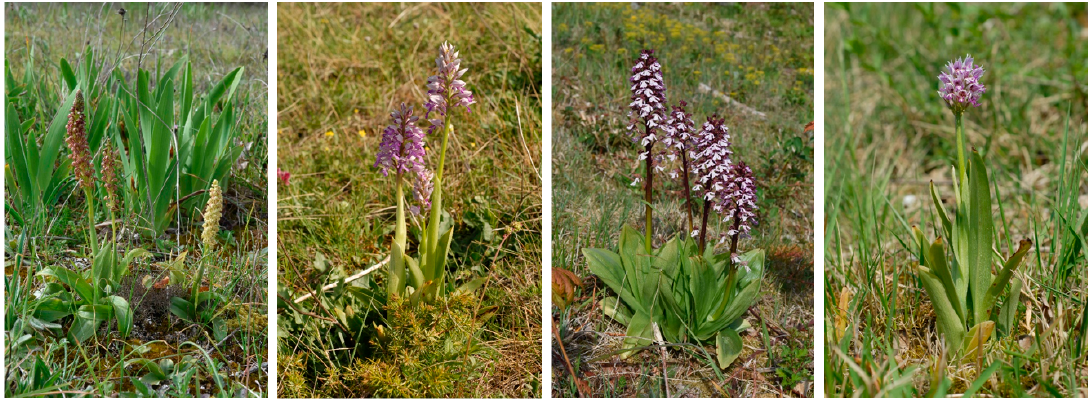
Figure 1. Overview of the four study species. From left to right: Orchis anthropophora , Orchis militaris , Orchis purpurea , and Orchis simia . All pictures courtesy of Daniel Tyteca.